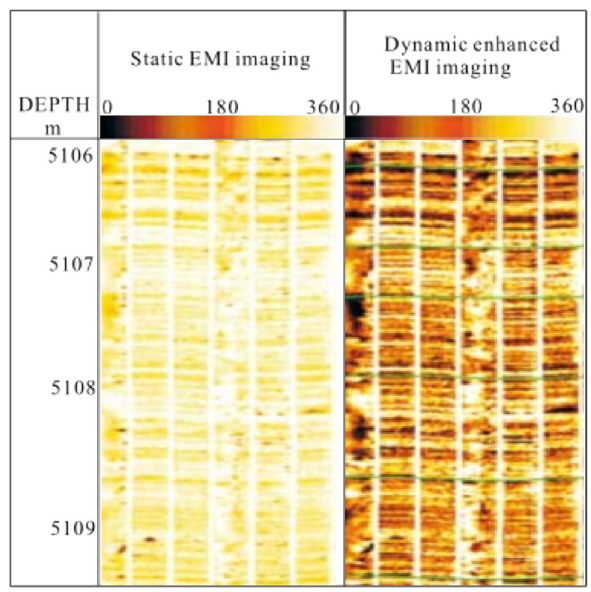
Fig. 15 The SW to NE orientation shown in the borehole caving by EMI in the Feixianguan Formation